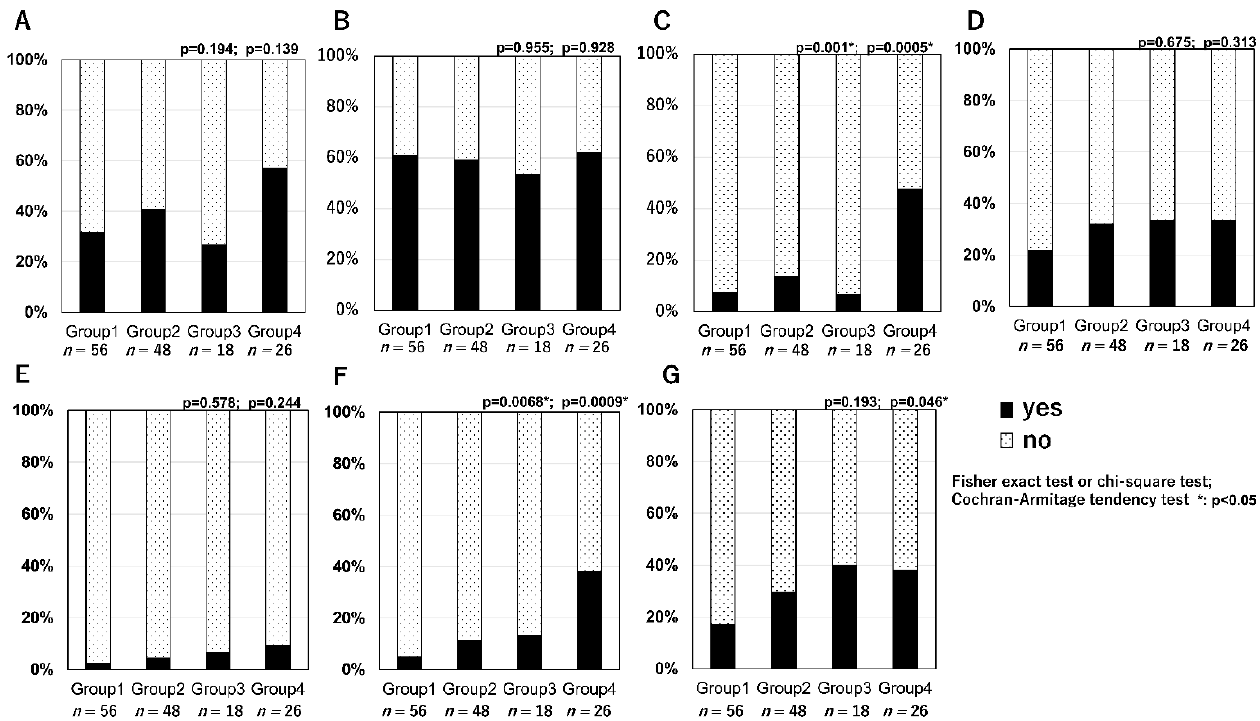
Figure 4. Specific situations wherein the patients with AMD felt in danger while driving. ( A ): failing to notice pedestrians, oncoming vehicles, and signs. ( B ): when driving at night (blur or glare). ( C ): discrimination of the signal colour. ( D ): when parking. ( E ): when changing lanes ( F ): when determining the vehicle spacing. ( G ): understanding the surroundings.